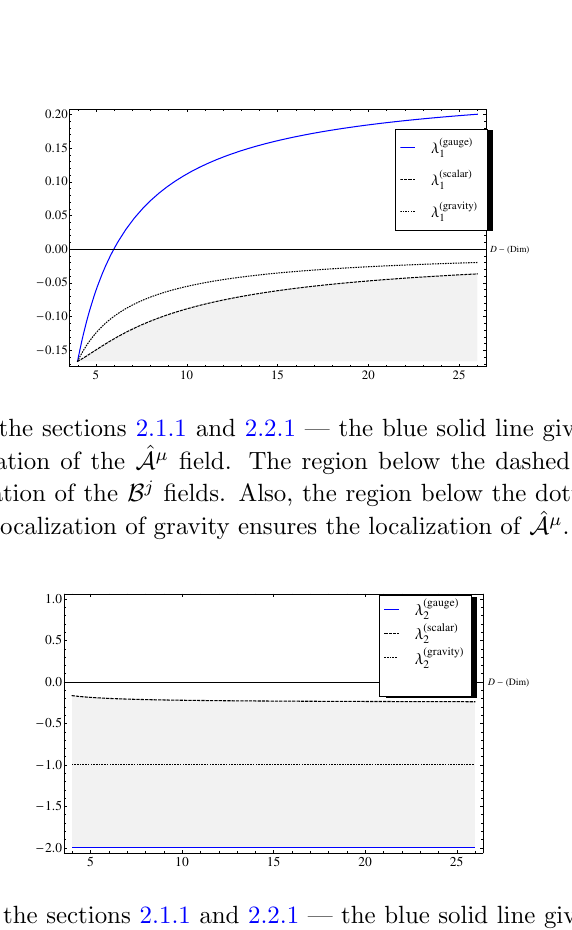
Figure 2 . Case (iii) of the sections 2.1.1 and 2.2.1 | the blue solid line gives the values of (cid:21) 2 ( D ) which allow the localization of the ^ A (cid:22) (cid:12)eld. The region below the dashed line shows the values which allow the localization of the B j (cid:12)elds. Also, the region below the dotted line are the values of (cid:21) 2 ( D ) for which the localization of gravity ensures the localization of ^ A (cid:22) . valid for any warp factor. However for the scalar components, it was only possible to (cid:12)nd an asymptotic zero-mode solution. Here, we will apply the general results obtained